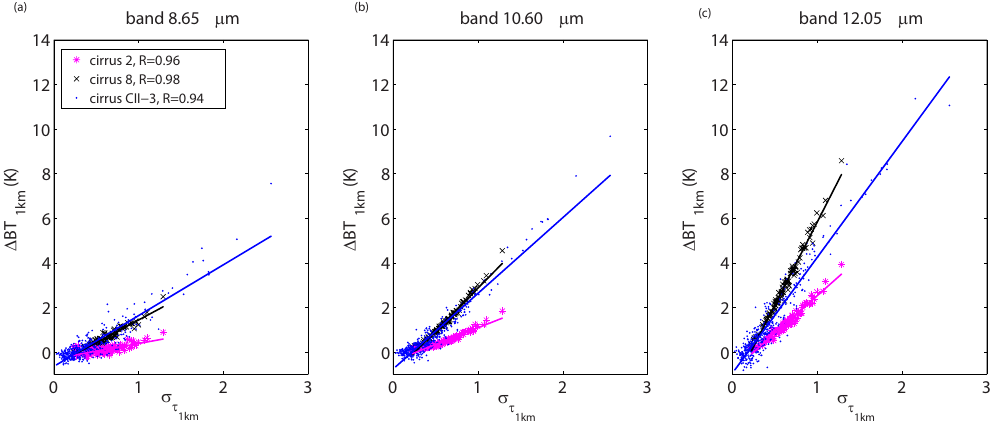
Figure 16. Brightness temperature differences, 1 BT 1km , viewed at the nadir as a function of the optical thickness standard deviation σ τ for cirrus 2, cirrus 8 and CII-3 and for the bands at 8 . 65µm, 10 . 60µm and 12 . 05µm. The cloud top of cirrus 2, cirrus 8 and cirrus CII-3 is 7.97km, 11.06km and 11.06 km, respectively, and the cloud base is at 7.60km, 11.06km and 9.06km,